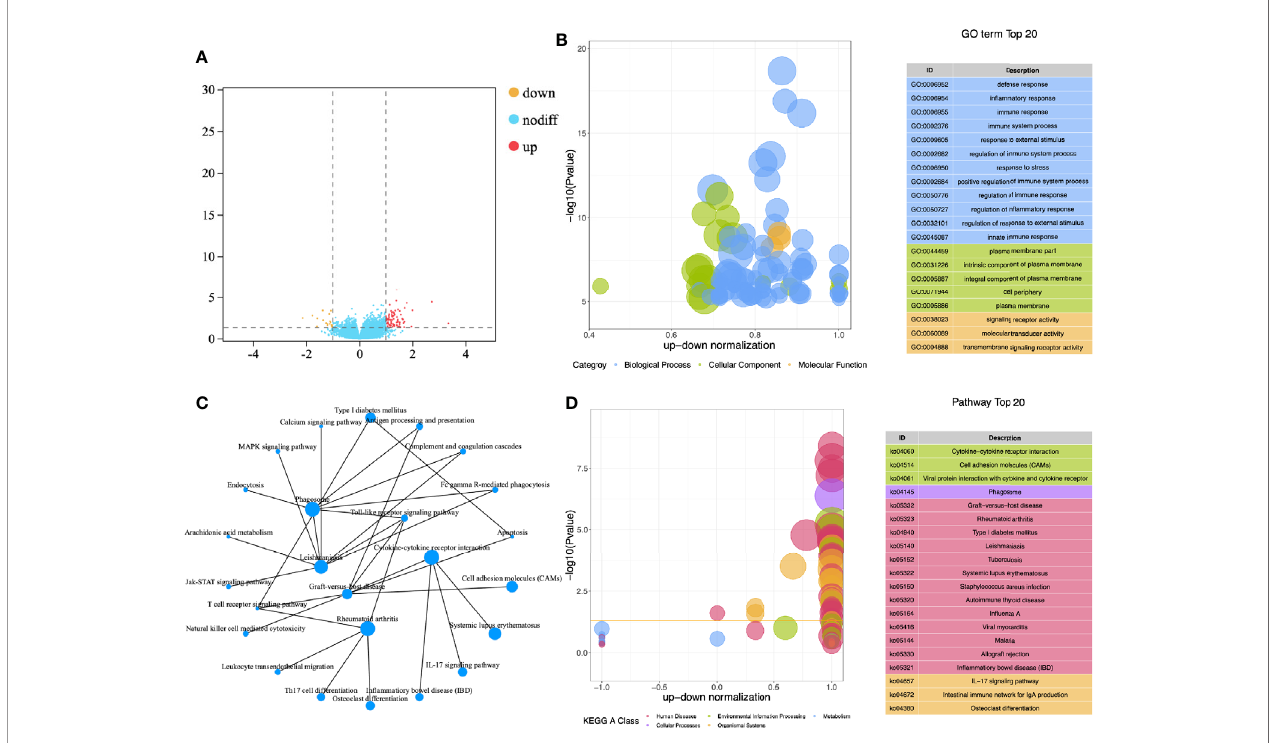
FIGURE 1 | Functional enrichment analysis of DEGs. (A) Volcano map for differential expression analysis; (B) Z-score bubble chart of Gene Ontology (GO) enrichment analysis; (C) Network diagram of KEGG enrichment analysis; (D) Z-score bubble chart of KEGG enrichment